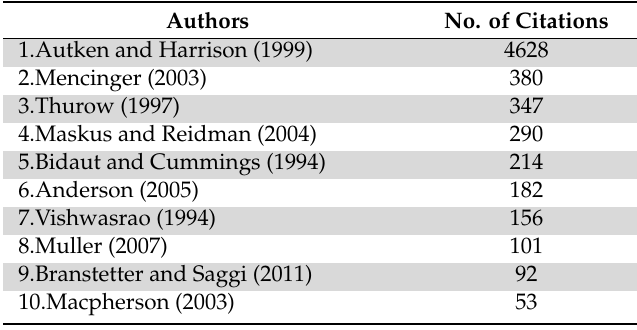
Table 2. The most cited authors regarding technology transfer (TT) and o ff set policy *. Authors No. of Citations